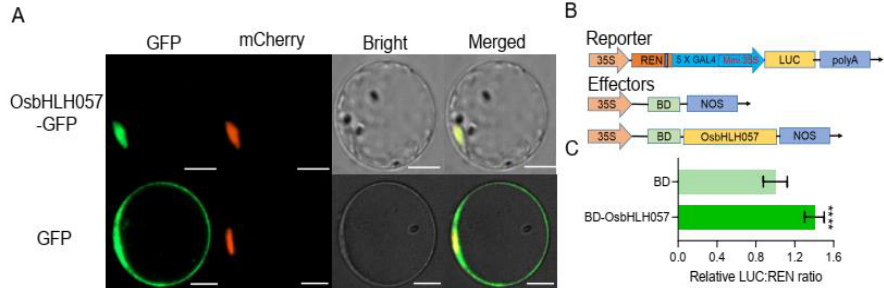
Figure 2. Subcellular localization and transcriptional activity of OsbHLH057. ( A ) Subcellular local- ization of OsbHLH057 in rice protoplasts. OsbHLH057 was fused with GFP to obtain the OsbHLH057-GFP fusion protein. Nucleus localization signal (NLS) fused with mCherry was used as a nuclear marker. The upper row indicates the fluorescent signal from co-expressing OsbHLH057-GFP and NLS-mCherry. As a negative control, the bottom row shows the fluorescent signal from co-expressing GFP and NLS- mCherry. Scale bars, 8 μm. ( B ) Diagram of vectors of